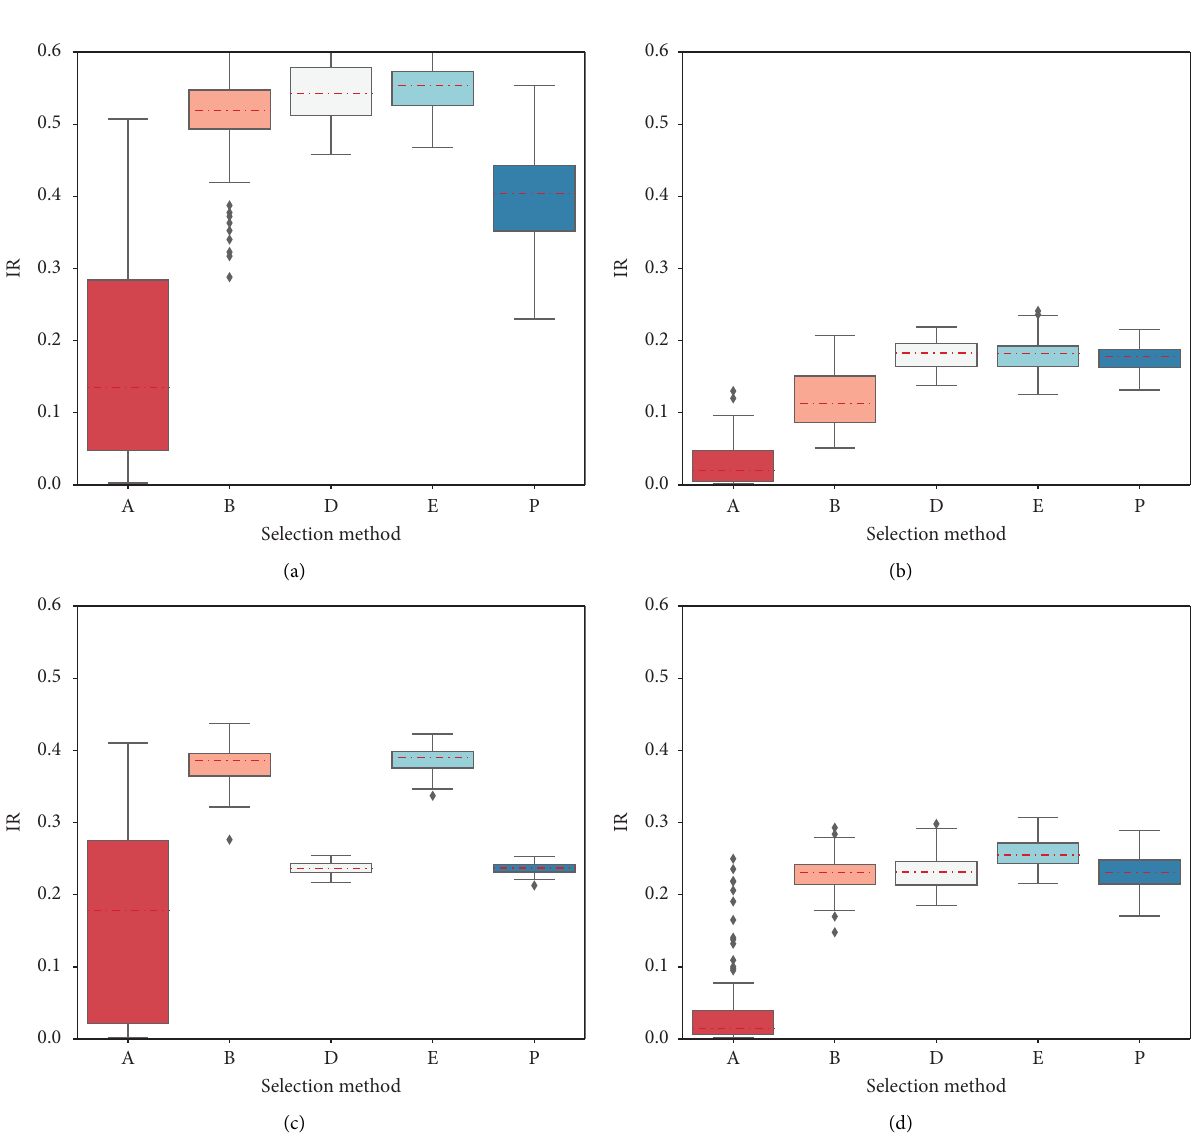
Figure 5: In L-Space for (a) EMT, (b) BC Transit, (c) Kolumbus, and (d) Auckland networks. pI � 0.05, pR � 0.0025, and T � 150 (boxplot diagram for A, B, D, E, and P